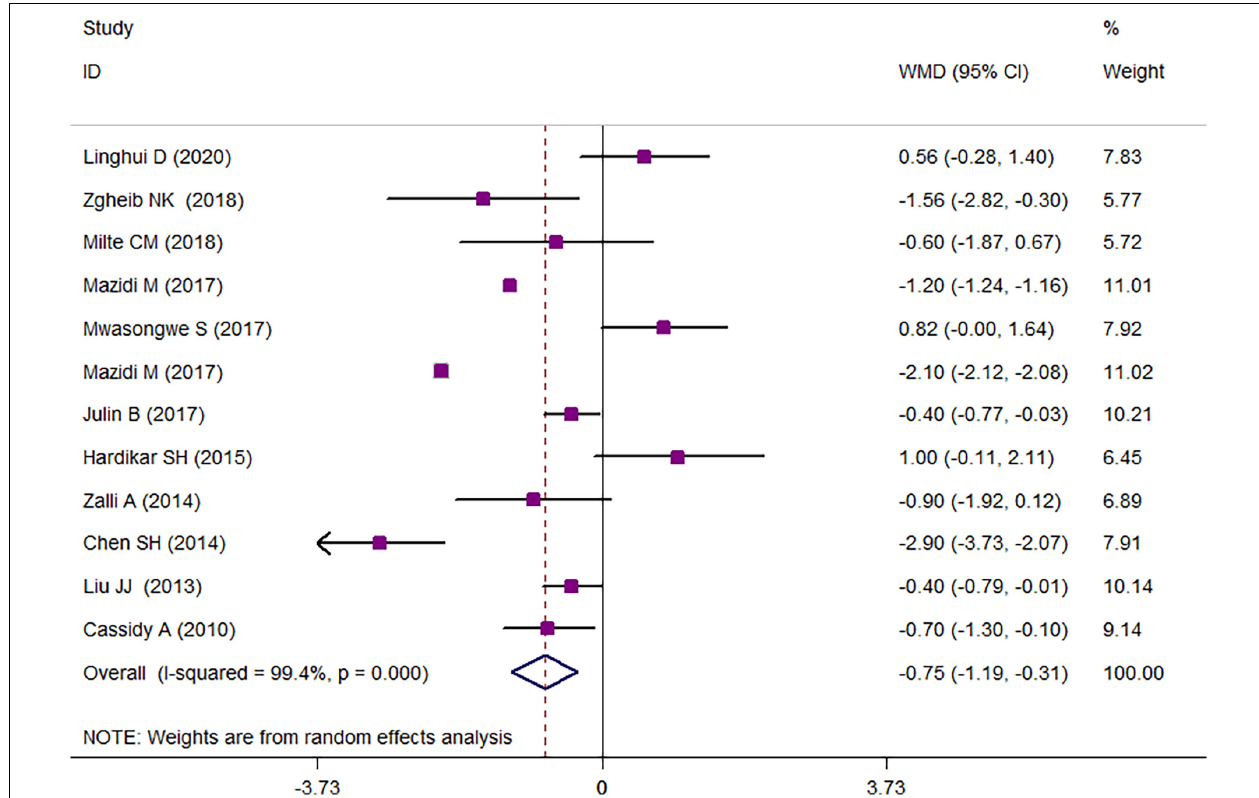
FIGURE 2 | Weighted mean difference (WMD) with 95% confidence interval (CI) of the comparison of BMI in the lowest vs. the highest leukocyte telomere